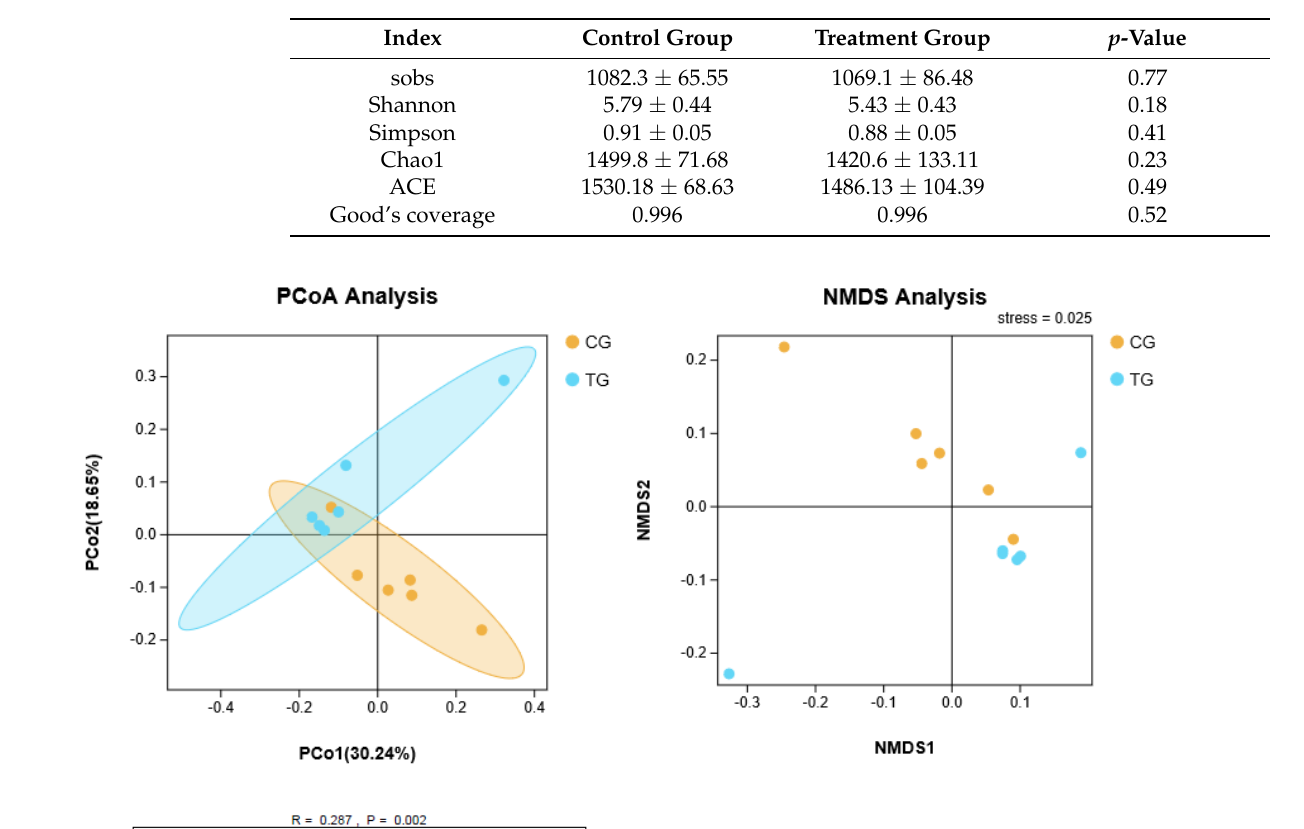
Table 3. p -value in α -diversity indices between control group and treatment group.